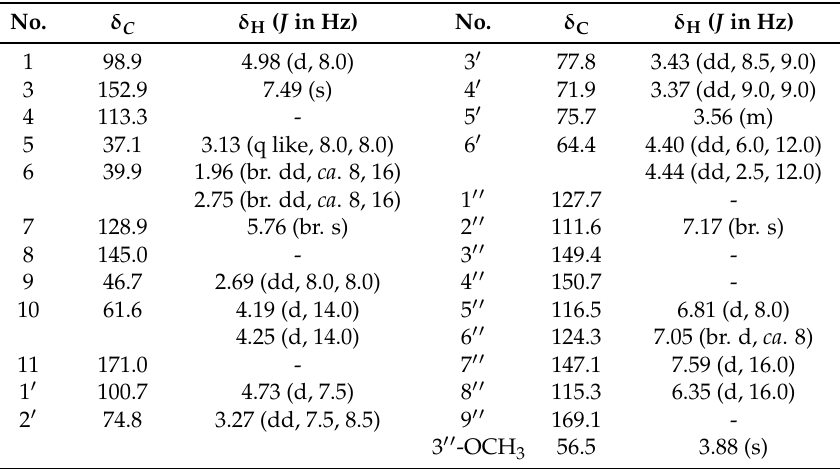
Figure 4. The main 1 H- 1 H COSY, HMBC and NOE correlations of 2 . Table 2. The 1 H- and 13 C-NMR data of 2 in CD 3